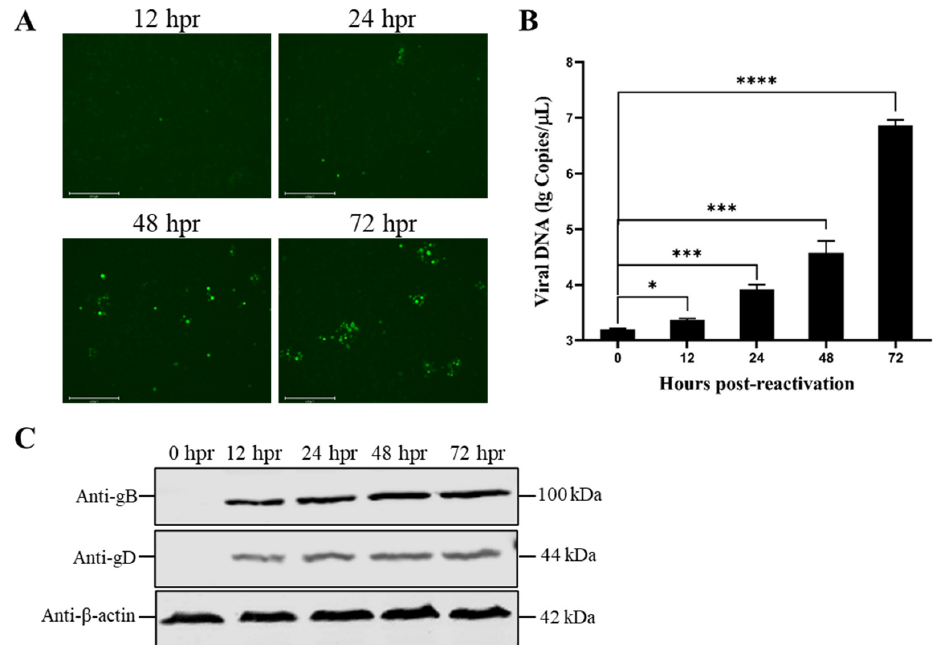
Figure 4. Reactivation of latent rPRV-EGFP. ( A ) Fluorescence spots of rPRV-EGFP during reacti-